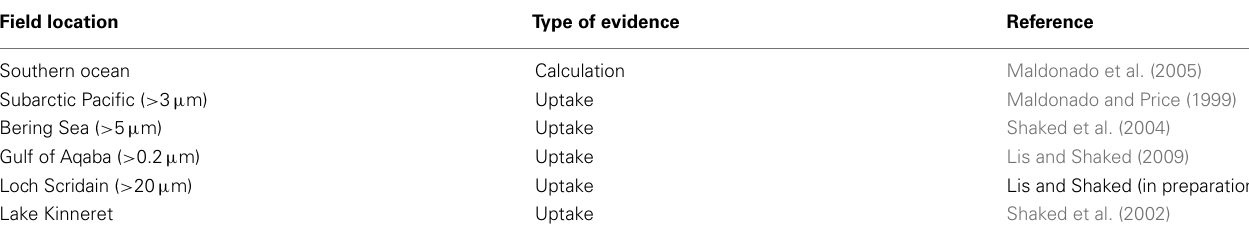
TableA2 | Experimental evidence showing the existence of the reductive iron uptake pathway in field